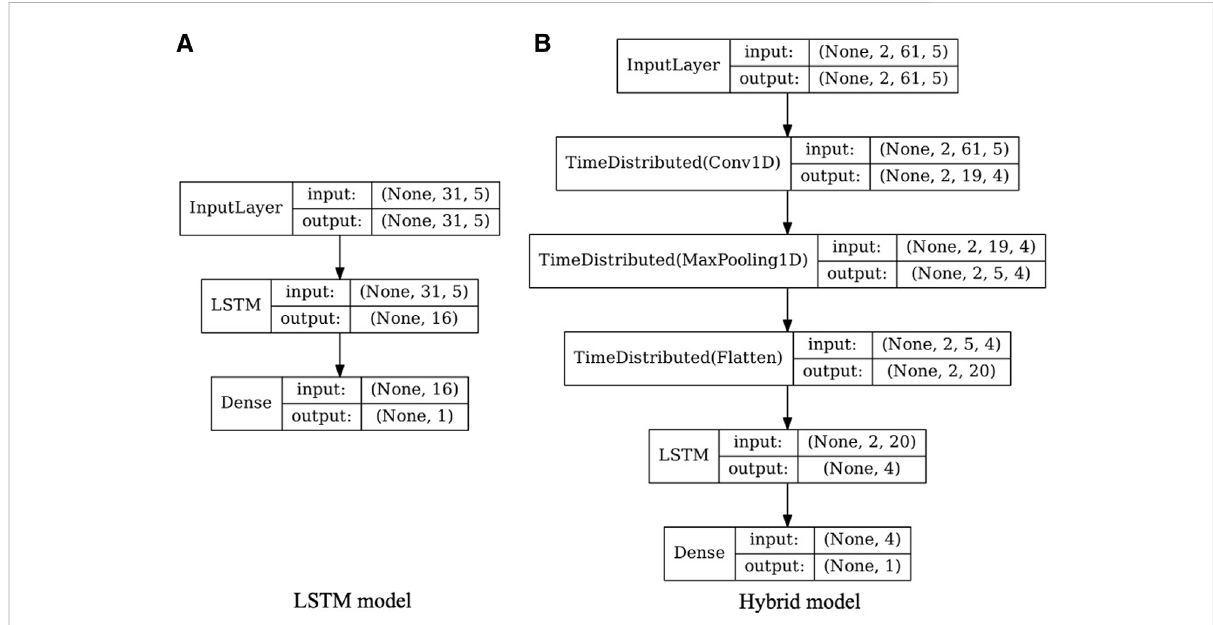
FIGURE 1 Keras model architecture for 30-min forecast of | d B H Section 2.2 for details.